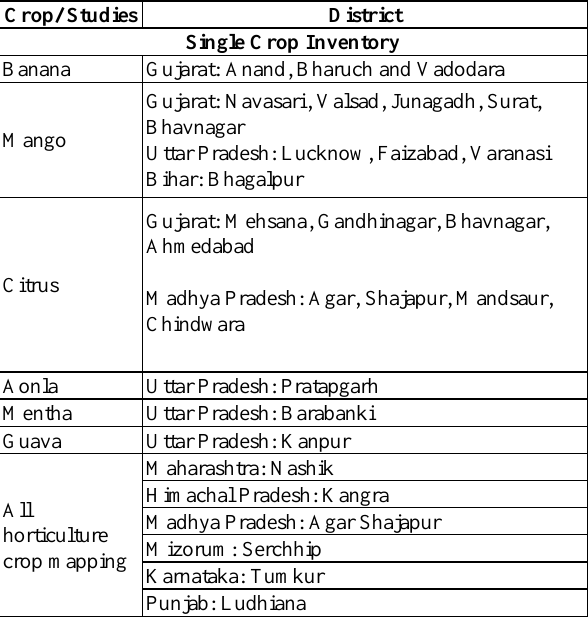
Table 1. Studies conducted for crop inventory and their study areas